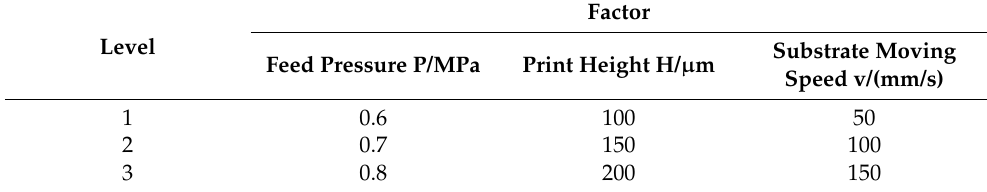
Table 3. Factor level table.